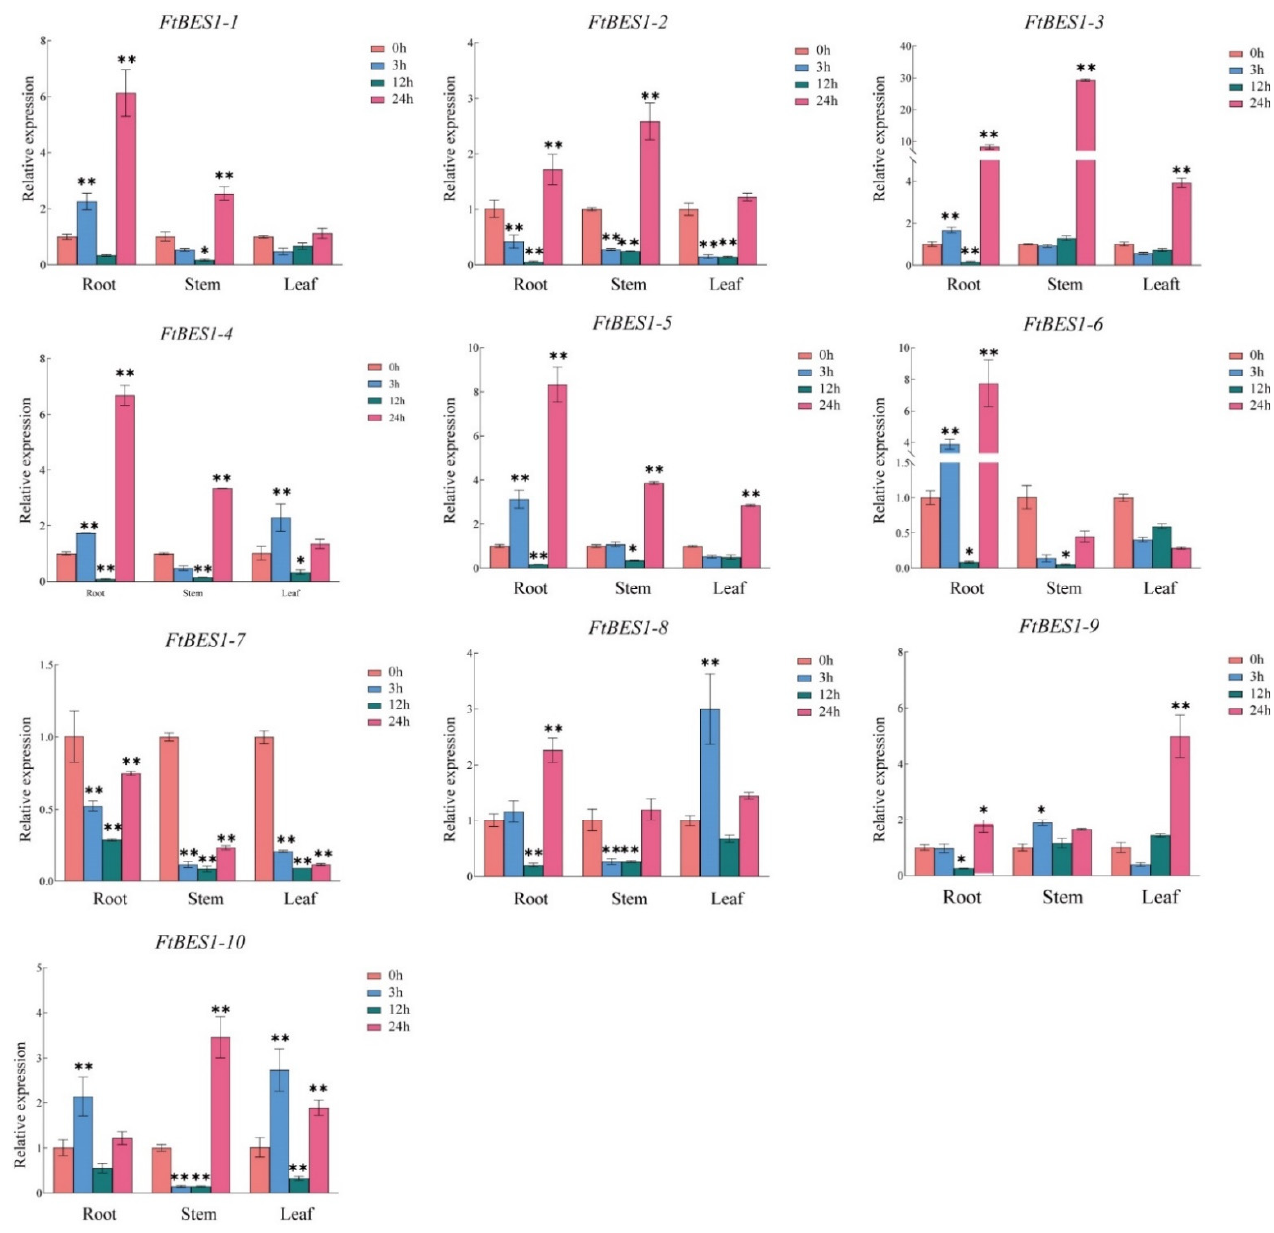
Figure 8. Expression levels of FtBES1 gene in different tissues after 100 μ M MeJA treatment. Different colors indicate different time of stress treatment. Three biological replicates were considered for each experiment. Error lines indicate the standard error of three independent biological replicates. * In the figure indicates significant differences calculated by t -test (* p < 0.05, ** p < 0.01).